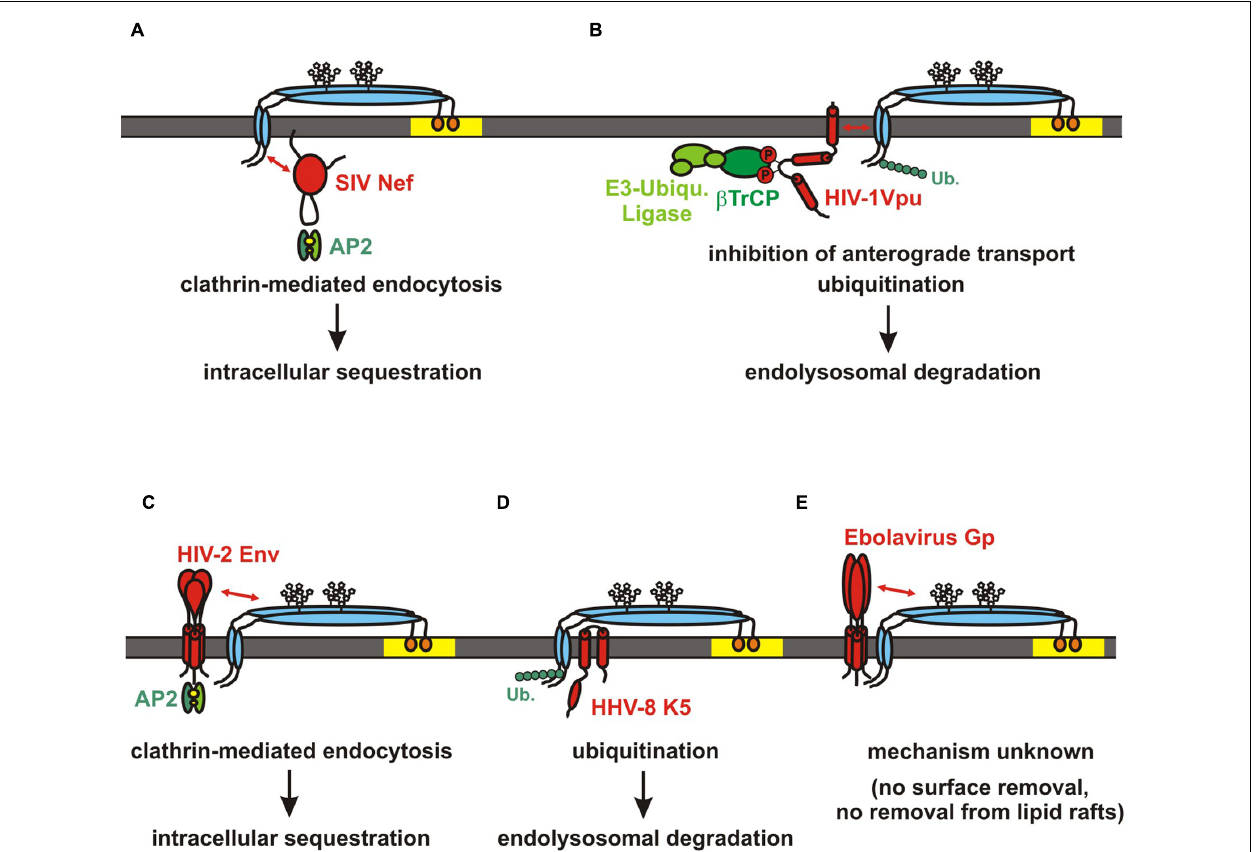
FIGURE 3 | Viral antagonists of tetherin. Schematic structure and mode of action are shown for (A) SIV Nef, (B) HIV-1 Vpu, (C) HIV-2 Env, (D) HHV-8 K5, (E) Ebolavirus Gp. Tetherin is indicated in blue, the viral antagonists are shown in red. SIV Nef and HIV-2 Env